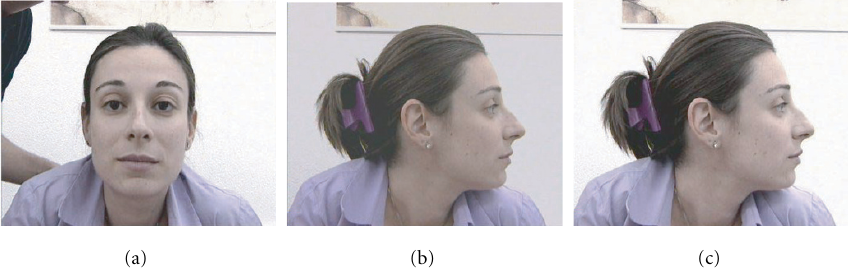
Figure 6: (a) Front image, (b) profile image, (c) profile image after equalization.